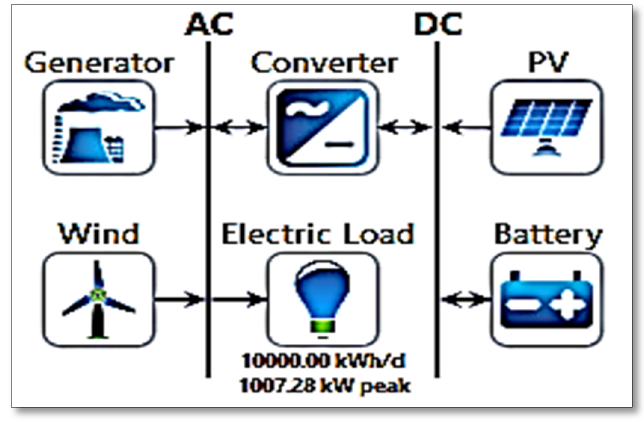
Figure 5. The optimum configuration model of hybrid PV/wind/diesel/battery system of the proposed tourist village in the